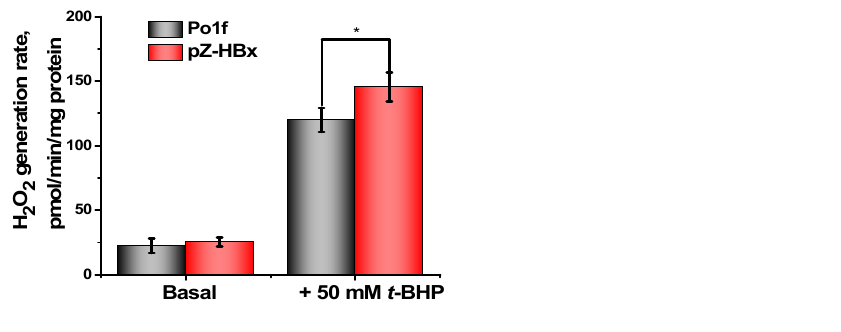
Figure 10. H 2 O 2 generation by Y. lipolytica mitochondria. The statistical analyses were carried out by the one-way ANOVA test. *: 0.01 < p < 0.05.